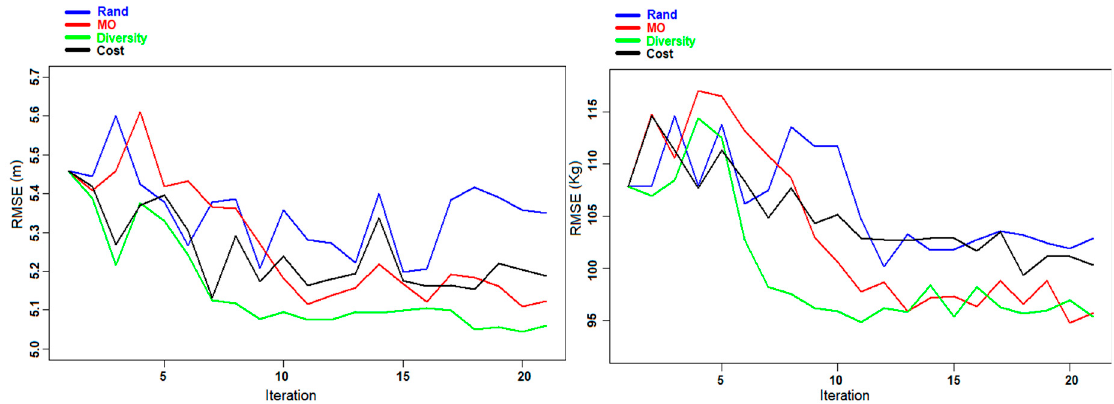
Figure 6. Experiment B: Evolution of the RMSE ( left panel ) and the cost ( right panel ) for AGB prediction for the Våler dataset during the different iterations.